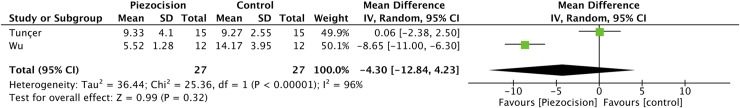
Forest plot demonstrates the overall en-masse retraction duration differences between piezocision and control groups by months.